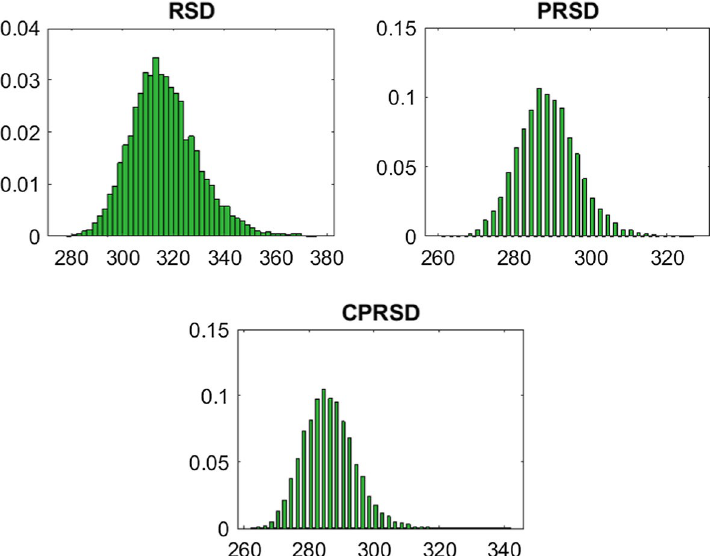
Fig. 12 Histogram of required number of encoding symbols for successful data retrieval for k =